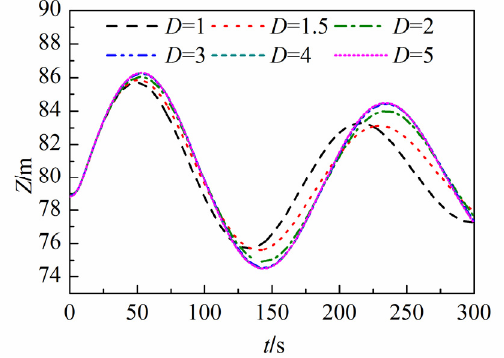
Figure 25. Effect of duct diameter on wind speed.